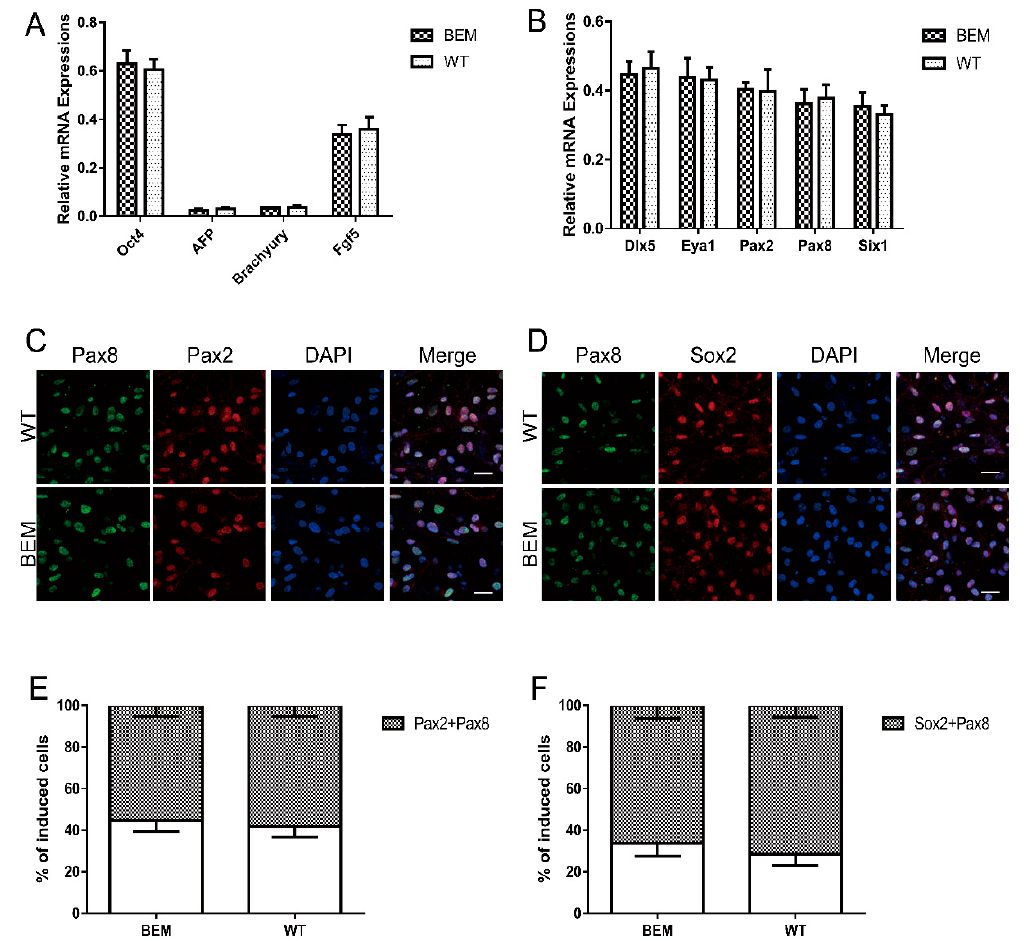
Figure 4. Targeted disruption of the essential E-box in Barhl1 enhancer does not a ff ect induction of EPL cells and otic progenitors from mESCs. ( A ) qRT-PCR analyses for expression of pluripotent cell-related marker Oct4 , visceral endoderm-related marker AFP , mesoderm-related marker Brachyury, and primitive ectoderm-related marker Fgf5 in cell aggregates derived from WT and BEM mESCs on day 7. There were no significant di ff erences in the mRNA expression levels of Oct4 and Fgf5 between two kinds of mESC-derived cells and no significant expressions of AFP and Brachyury in these induced cells, indicating the transition of both mESCs to EPL cells. Data are mean ± SEM ( n = 3). ( B ) qRT-PCR analyses for expression of otic markers Dlx5 , Eya1 , Pax2 , Pax8, and Six1 in WT-and BEM-derived cultures at day 21. No significant di ff erences in the mRNA expression levels of Dlx5 , Eya1 , Pax2 , Pax8, and Six1 between both kinds of mESC-derived cells were detected. Data are mean ± SEM ( n = 3). ( C , D ) Immunostaining analyses of otic markers Pax2 / Pax8 ( C ) and Pax8 / Sox2 ( D ) in WT- and BEM-derived cultures at day 21. Scale bars, 20 µ m. ( E , F ) The percentages of double-immunopositive cells for Pax2 / Pax8 (E) and Pax8 / Sox2 (F) in WT- and BEM-derived cultures at day 21. There were no significant di ff erences in the percentages of double-immunopositive cells for Pax2 / Pax8 and Pax8 / Sox2 between these two mESC-derived cells. Data are mean ± SEM ( n =